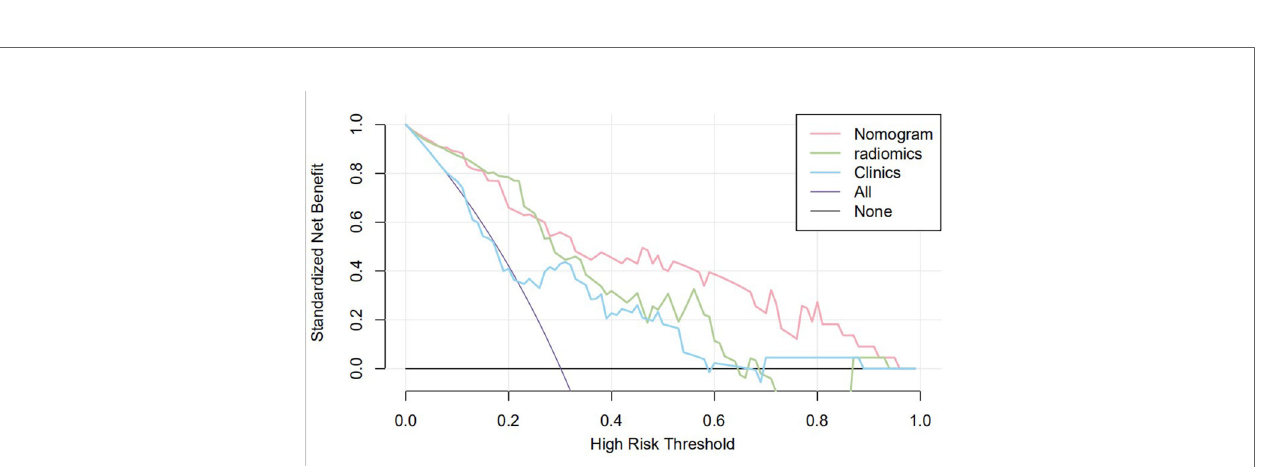
FIGURE 7 | Clinical decision curve of the three models. The X-axis represents the threshold probability, and the Y-axis represents the net bene fi t. The decision curve showed that if the threshold probability of a patient was within the range from 25% to 95%, using the joint nomogram to predict csPCa occurrences added more bene fi t than the biopsy-all-patients scheme or the surveil-all-patients scheme.